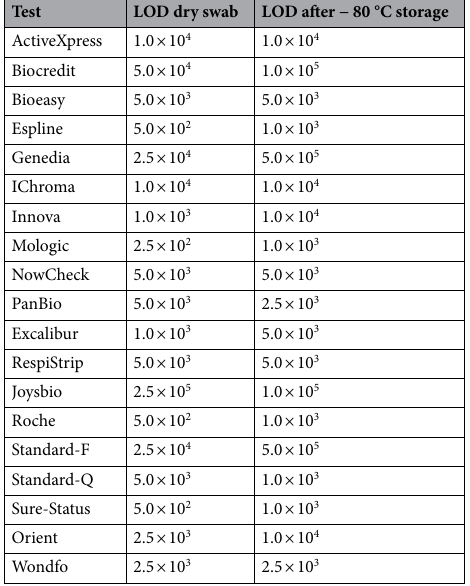
Table 1. LOD after 1 week − 80 °C storage and one freeze-thawed